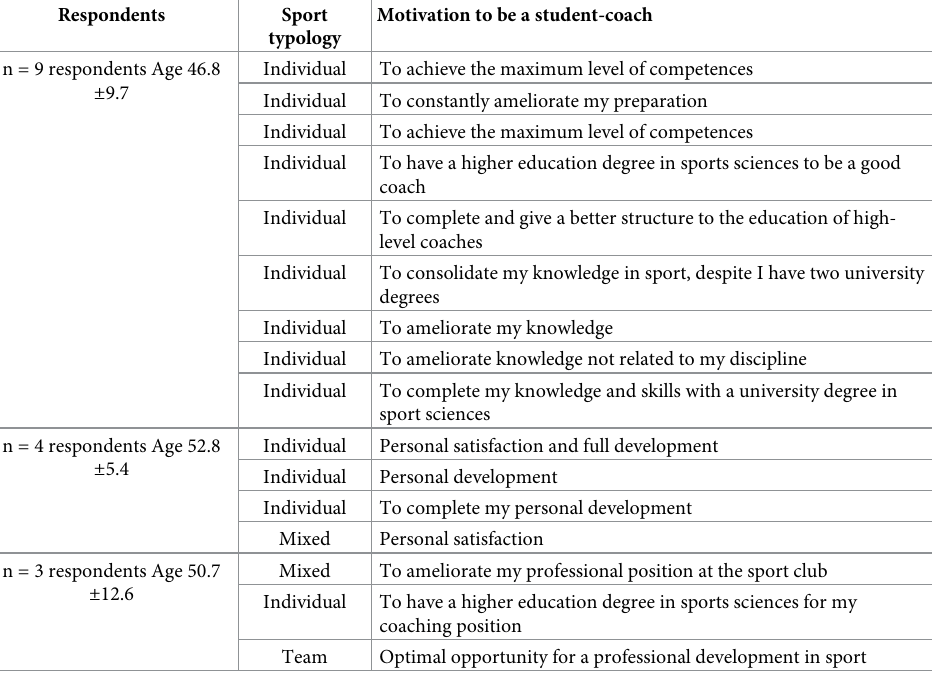
Table 2. Motivations (e.g., push factors) of student-coaches to enrol in a sport-related DC academic path in rela- tion to the age and sport discipline. Respondents